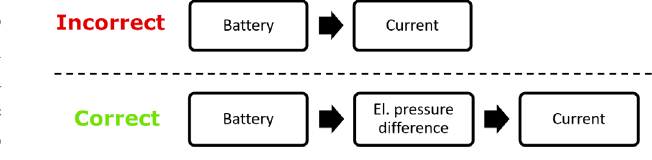
FIG. 17. An illustration to help students reflect on their own thinking when analyzing circuits. The incorrect way to analyze circuits is to think of the battery as a device that supplies a constant current and not a constant voltage (top). Instead, students must realize that the battery maintains an electric pressure difference, e.g., across a light bulb, that in turn leads to a current